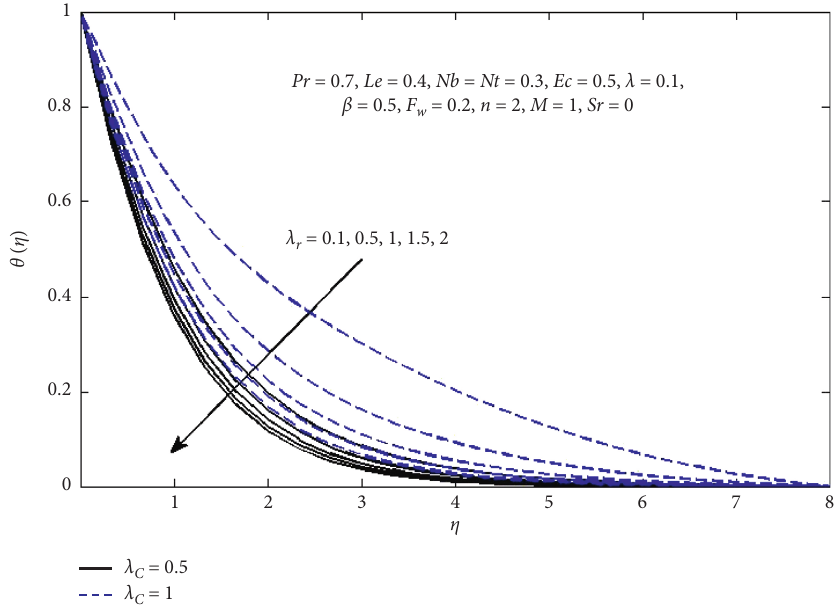
Figure 9: Variation of temperature θ concerning η with various values of λ